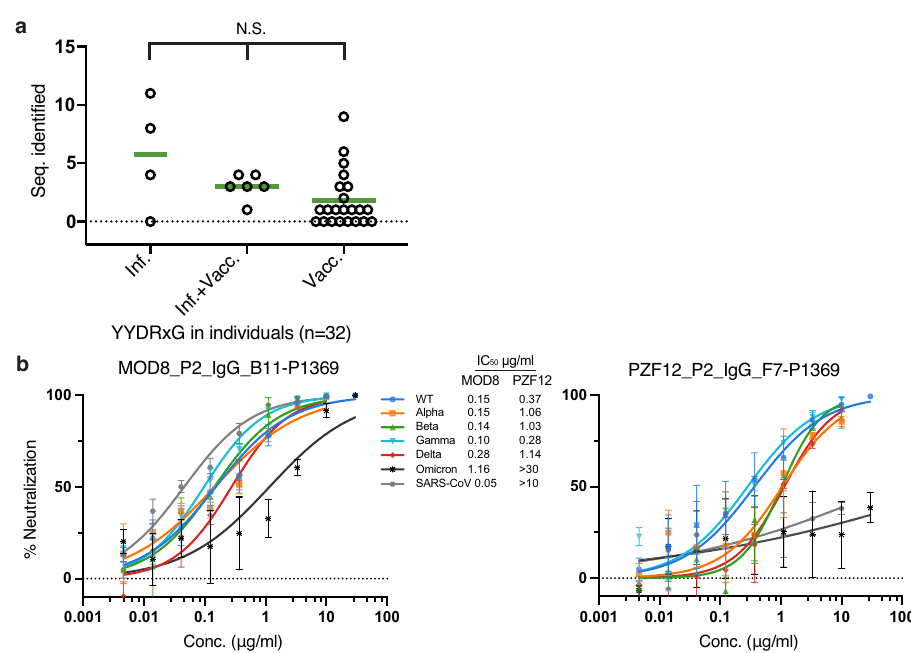
Fig. 6 YYDRxG motif can potentially serve as a biomarker of broad neutralization against SARS-CoV-2 VOCs. a YYDRxG antibodies sequenced from COVID-19 and vaccinated individuals. The number of YYDRxG antibody sequences identi fi ed in each individual ’ s antibodies (Seq. identi fi ed) were split into three groups according to the medical history reported in their original publication 33 – 35,38,39,42 . All antibody sequences ( n = 17,536) sequenced from COVID-19 patients without vaccination ( n = 4), COVID-19 patients vaccinated post-recovery ( n = 6), and vaccinees without COVID-19 history ( n = 22) are included in this analysis. Non-parameter Kruskal-Wallis test was used to compare the number of YYDRxG antibodies isolated in each group. N.S., not signi fi cant ( P > 0.05). Sequence counts for each individual are included in Supplementary Table 3. b Representative antibodies with only sequence information available show potent neutralization. MOD8_P2_IgG_B11-P1369 and PZF12_P2_IgG_F7-P1369, were selected from 72 sequences, which do not have any neutralization data available (Supplementary Table 2). The two antibodies were cloned, expressed, puri fi ed, and tested against SARS-CoV-2, VOCs and SARS-CoV in a pseudovirus neutralization assay. Error bars indicate standard deviation (SD) of at least two biological replicates. Neutralization potency, i.e., IC 50 s, are shown between the two